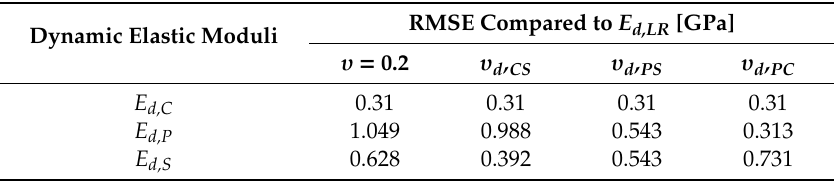
Table 1. RMSE values between the three velocity dynamic elastic moduli ( E d,C , E d,P or E d,S ) and the